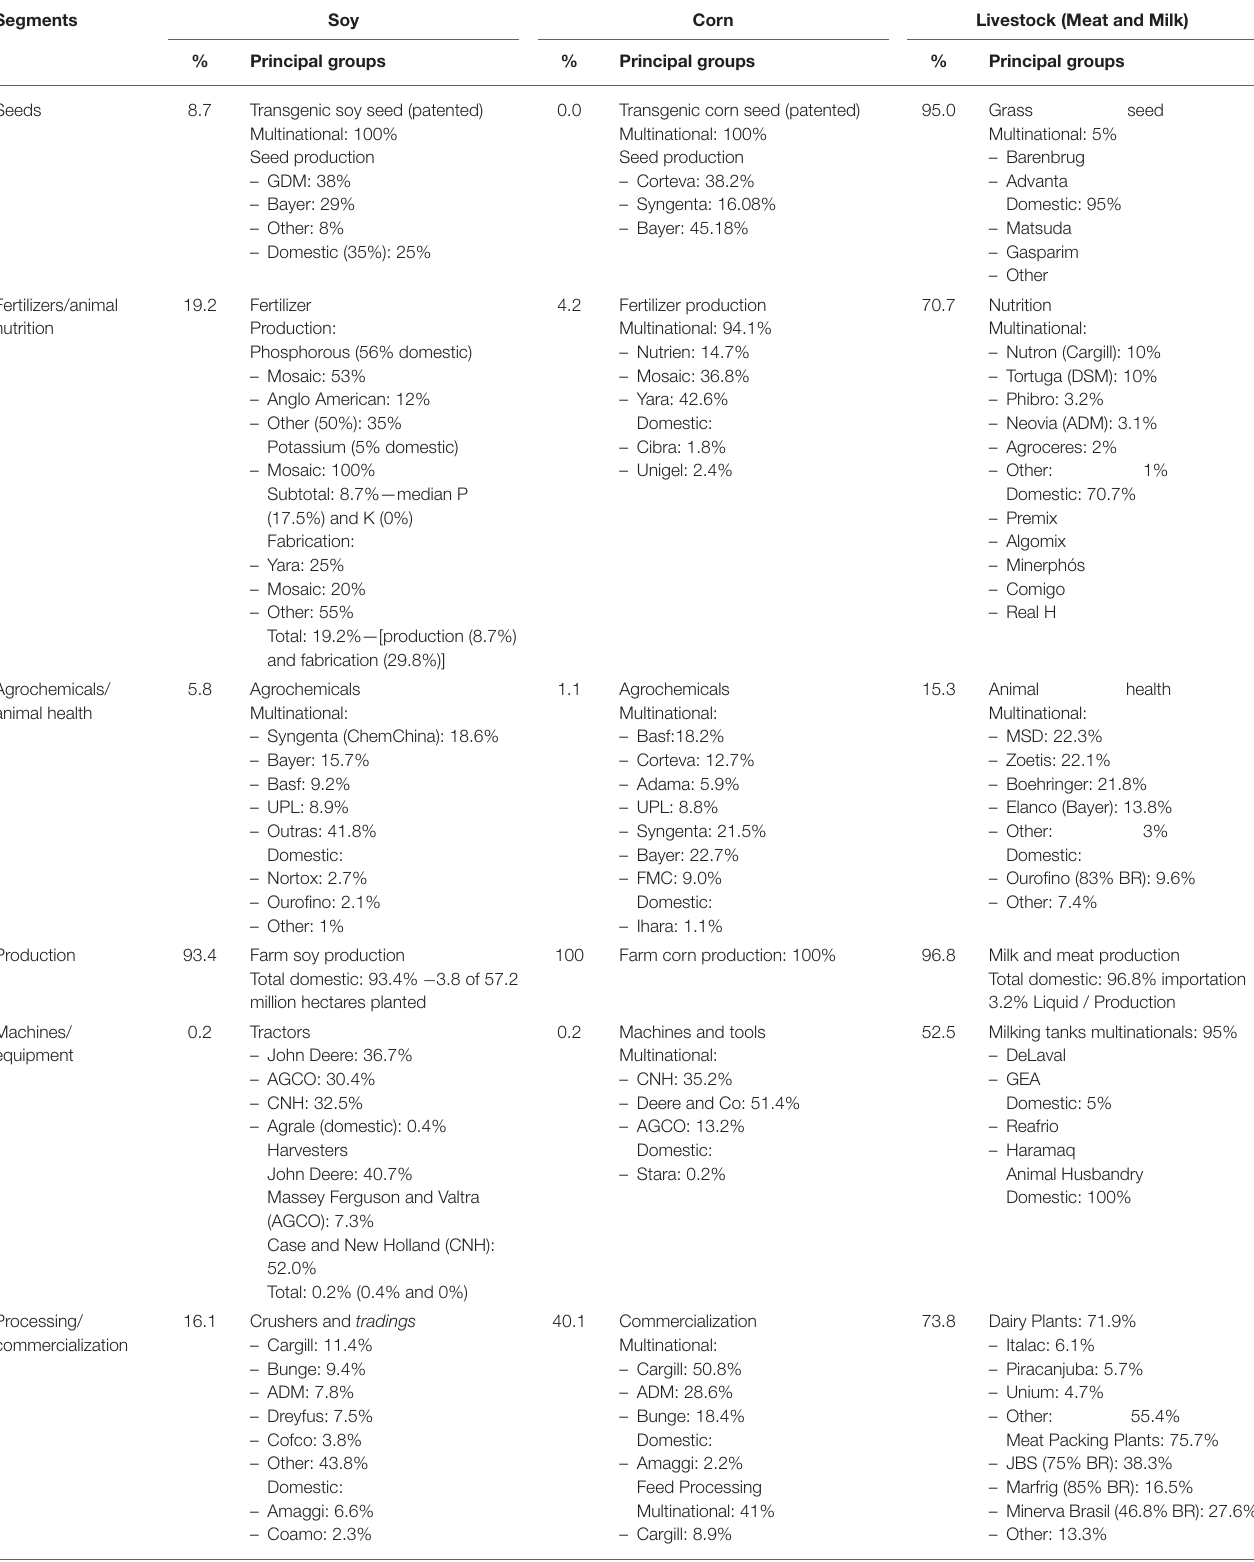
TABLE 1 | Participation of domestic groups in the main segments of the soybean, corn and beef production chains, 2019. Segments Soy Corn Livestock (Meat and Milk) % Principal groups % Principal groups % Principal